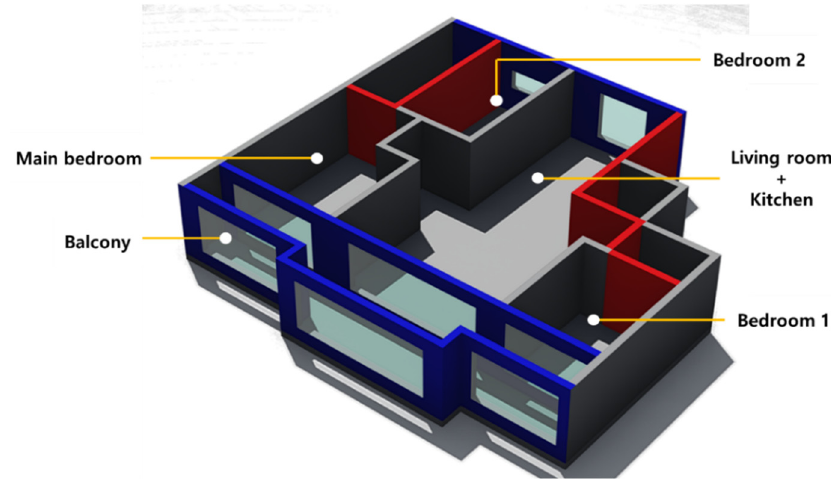
Figure 4. 3D view of the investigated apartment house.